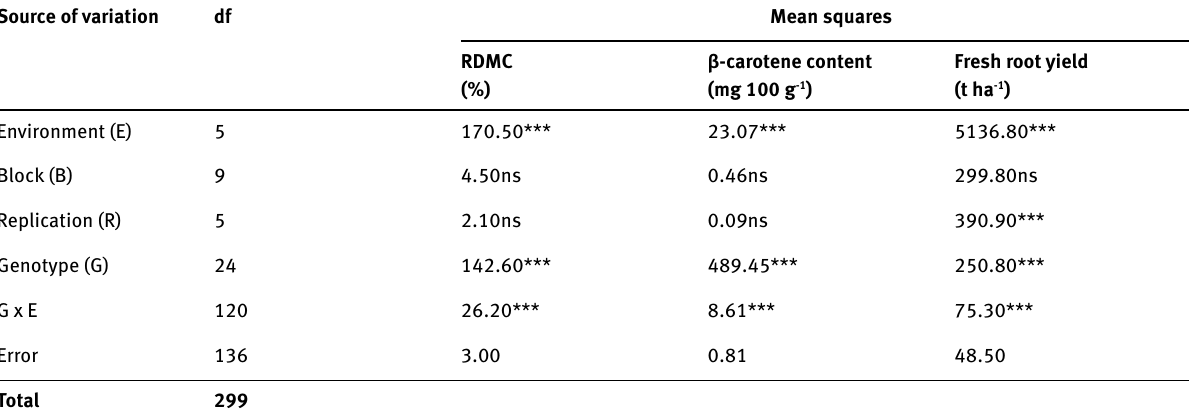
Table 3: Analysis of variance of RDMC, β-carotene content and fresh root yield of sweetpotato genotypes evaluated across six environments Source of variation